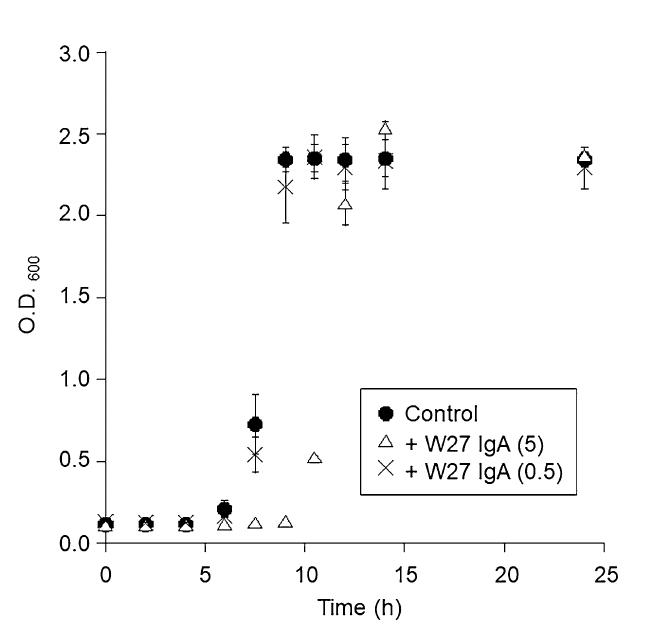
Figure 4. Growth of isolated Escherichia coli subcultured in Gifu Anaerobic Medium with 5.0 or 0.5 µg/mL W27 IgA [+ W27 IgA (5) or + W27 IgA (0.5)] or without IgA (Control). Growth is represented as the OD 600 . Data are shown as means ± standard deviation (n =